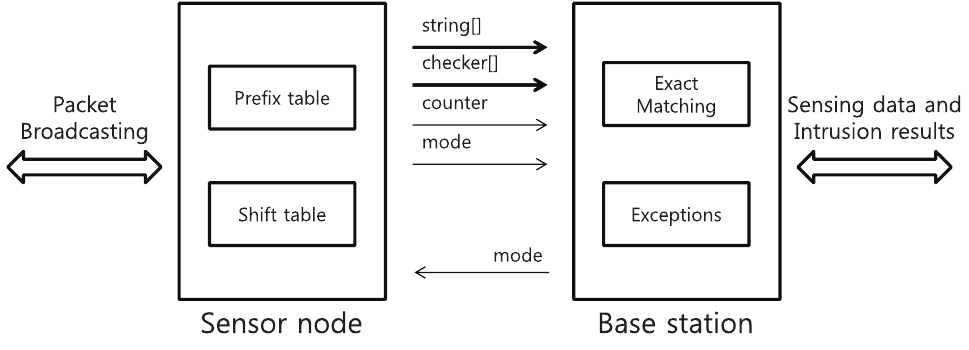
Figure 5. The packet messages between sensor nodes and a base